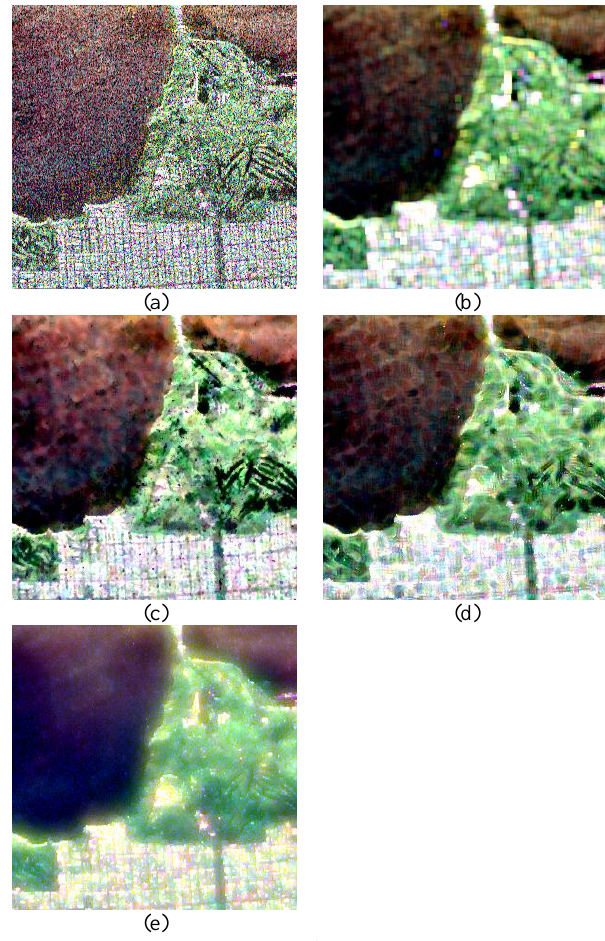
Figure 3. Pauli decomposition of the original AIRSAR image over San Francisco and its filtered results. (a) AIRSAR L-band data. (b) Boxcar filter. (c) IDAN filter. (d) Refined Lee filter. (e) PoRTV